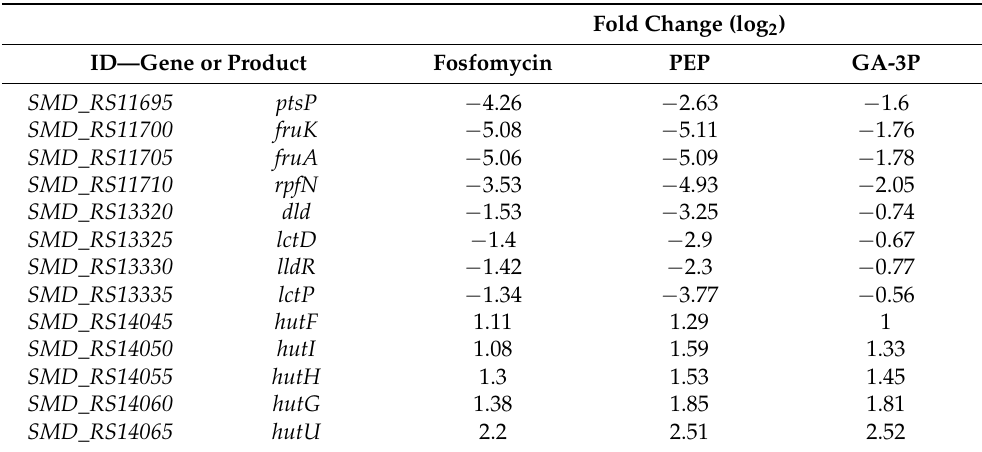
Table 4. Main metabolic and transport genes presenting changes in their expression levels in the presence of fosfomycin, PEP, or